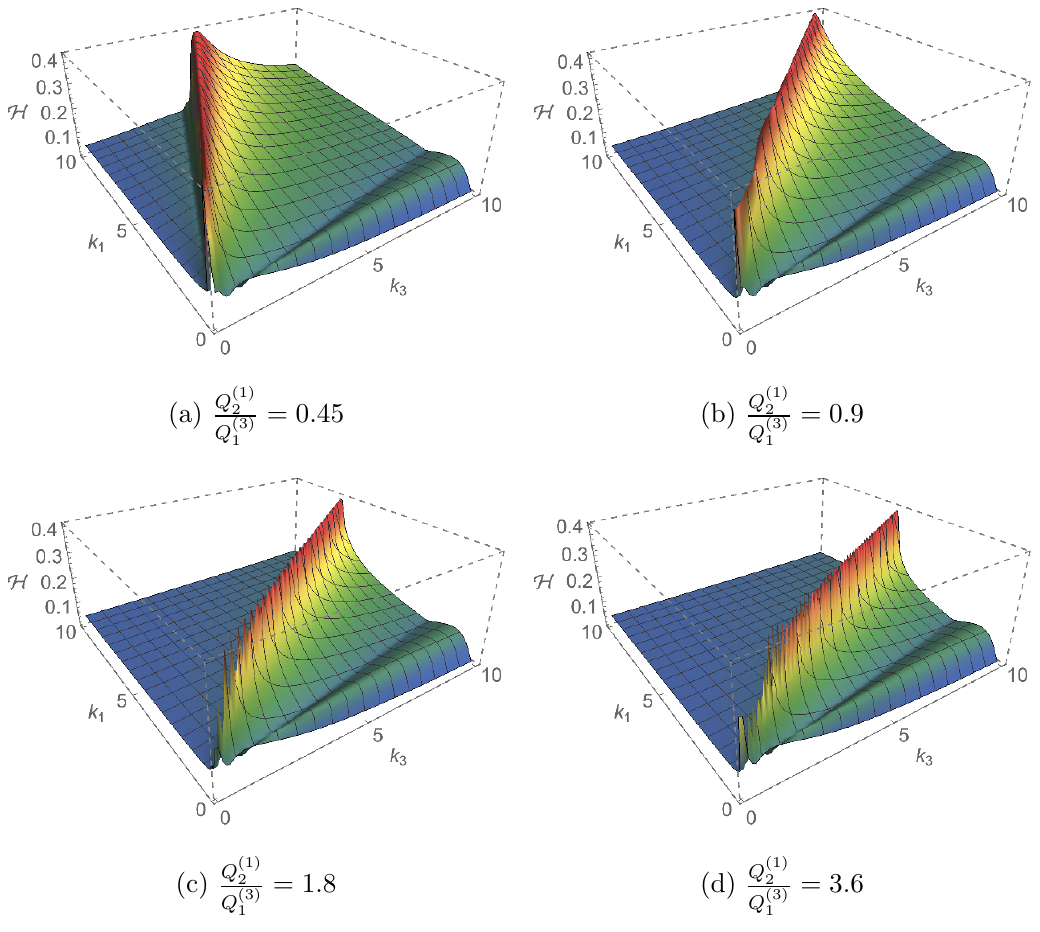
Figure 5 . The entropy parameter H as a function of the dipole charges k 1 and k 3 and one charge (1) ratio Q 2 Q (3)